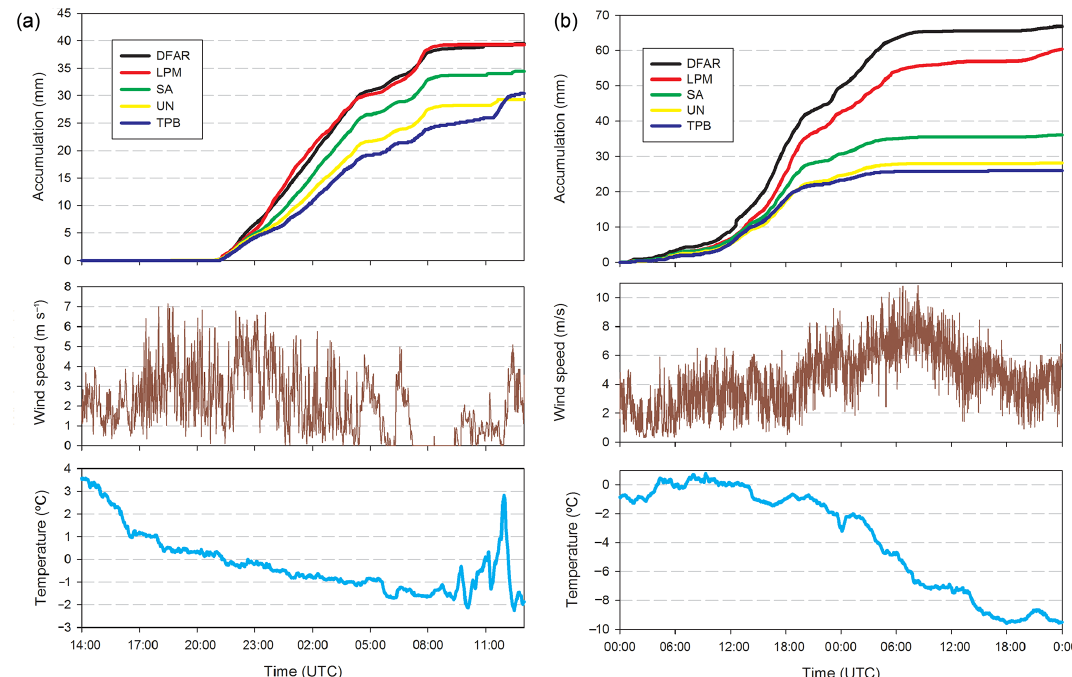
Figure 3. Accumulated precipitation, wind speed and temperature at Formigal–Sarrios during snowfall events on (a) 16–17 January 2015 and (b) 26–28 December 2014.